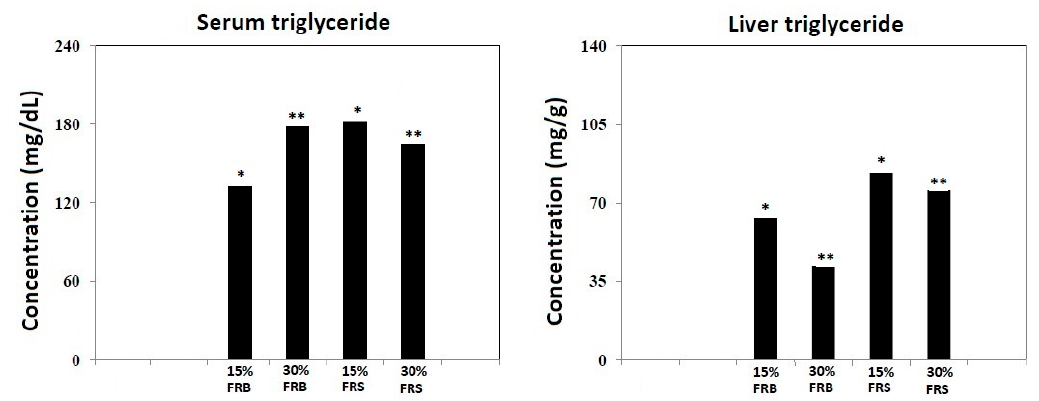
Figure 5. Effects of fermented rice bran (FRB) and fermented rice germ and soybean (FRS) on triglyceride concentrations in the liver and serum. * Statistical significance at p < 0.05. ** Statistical significance at p < 0.05.